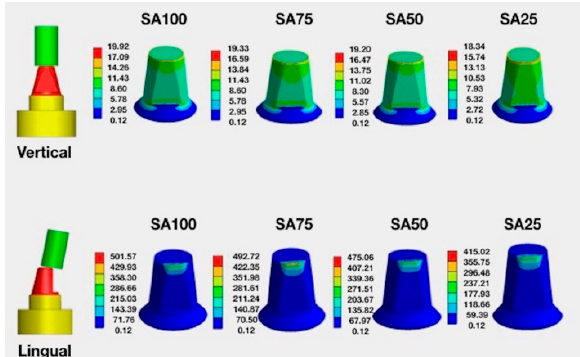
Figure 6. Distribution of stress in zirconia specimens. (Top) The vertical load of 300 N from lingual (L) view. (Bottom) Oblique 10-degree load of 300 N on the lingual marginal ridge. From the left to right are loading models: SA100, SA75, SA50, and SA25. Appl. Sci. 2019 , 9 , x FOR PEER REVIEW